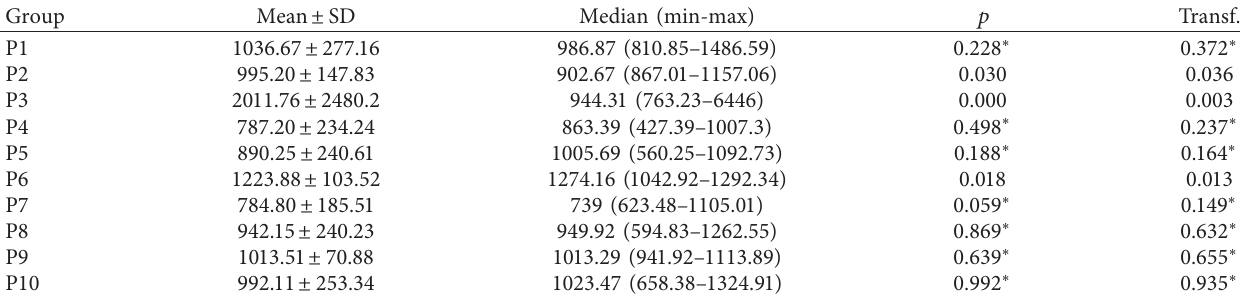
Table 5: Descriptive statistics and normality testing of collagen thickness data using the Shapiro–Wilk test in micrometer. Group